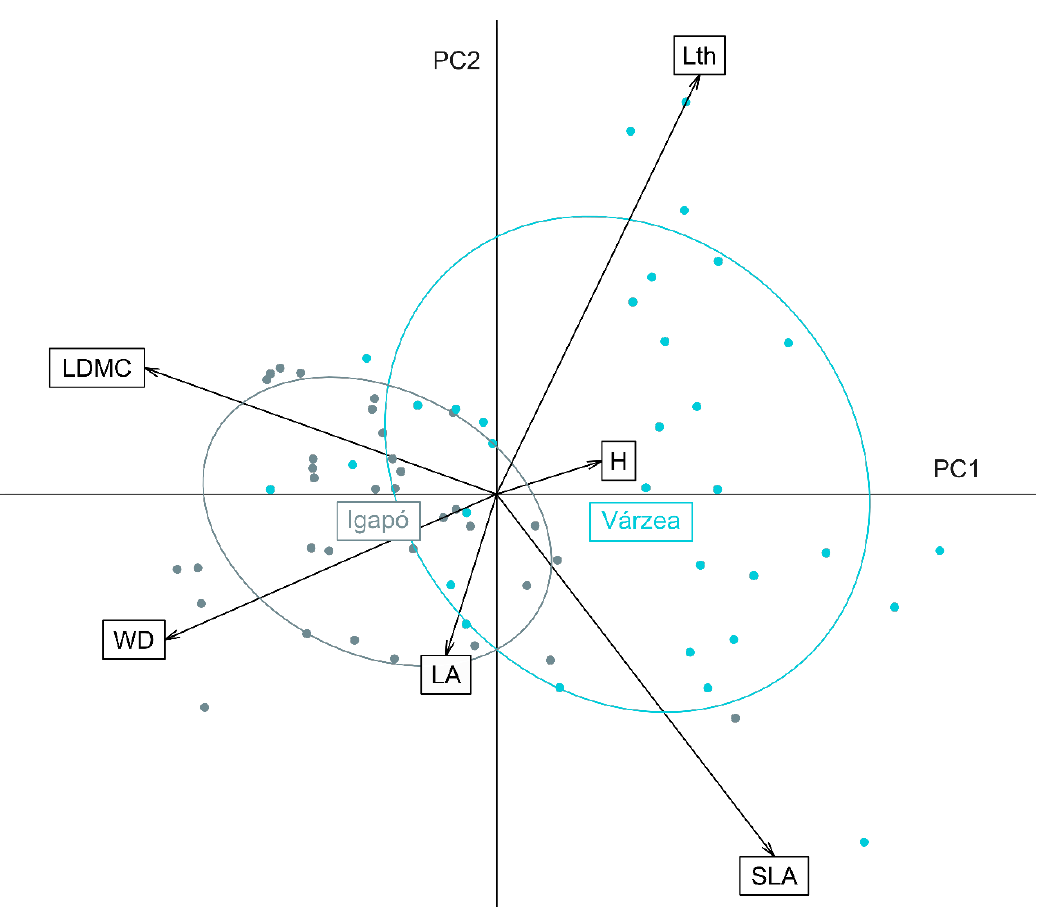
Figure 2. Principal component analysis (PCA) showing the relationship between the evaluated functional traits and the two types of floodplain forests. Each point represents the individuals sampled and the colors indicate the forest to which they belong to: várzea (blue) or igapó (gray). LA = leaf area; SLA = specific leaf area; LDMC = leaf dry matter content; Lth = leaf thickness; WD = wood density; H = plant height.